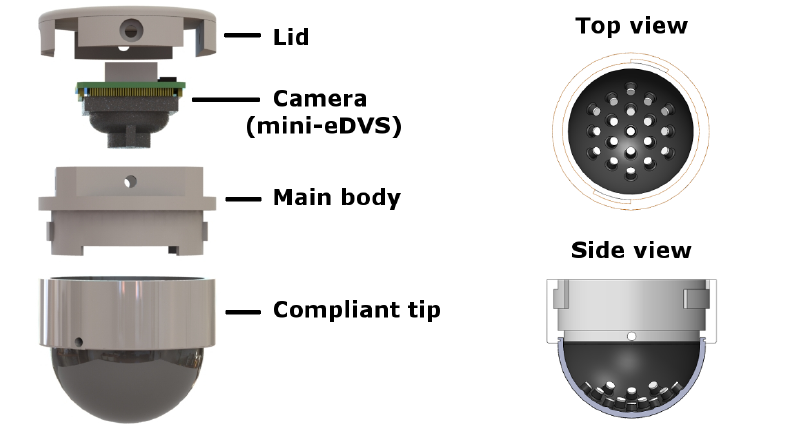
Figure 1. Left Panel : The NeuroTac—a neuromorphic version of the TacTip sensor. A lid and casing enclose the event-based camera (mini-eDVS), which, in turn, is held above a 3D-printed silicone tip with small rubber-like pins internally protruding. Right panel : Top and side views of the NeuroTac compliant skin, displaying the internally protruding pins that mimic the structure of human